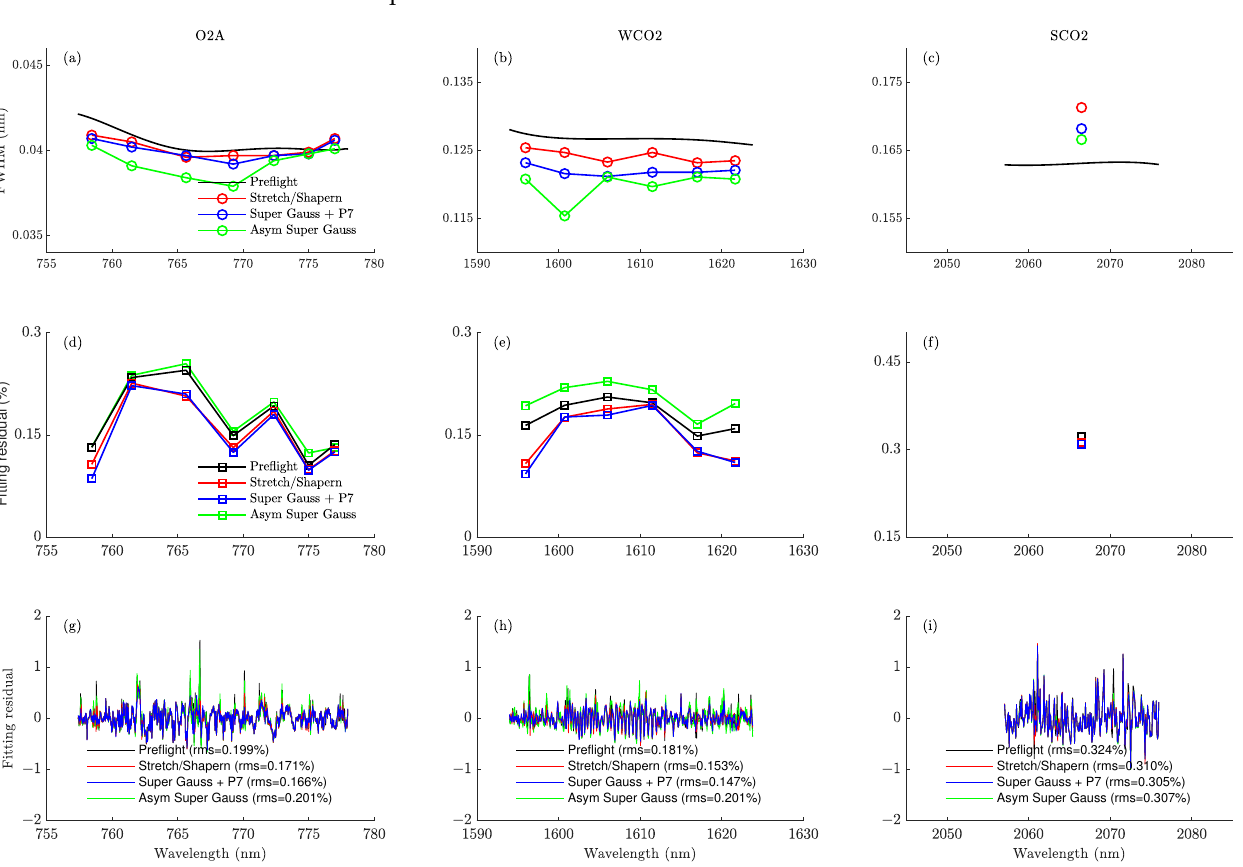
Figure 4. ( a – c ) FWHM of retrieved ILS as a function of wavelength for three TanSat bands at footprint 1 on 1 March 2017. The black line denotes preflight ILS FWHM. ( d – f ) Average fitting residual of each fitting window using four different ILS functions. ( g – i ) Similar to ( d – f ) but for the fitting residual at each